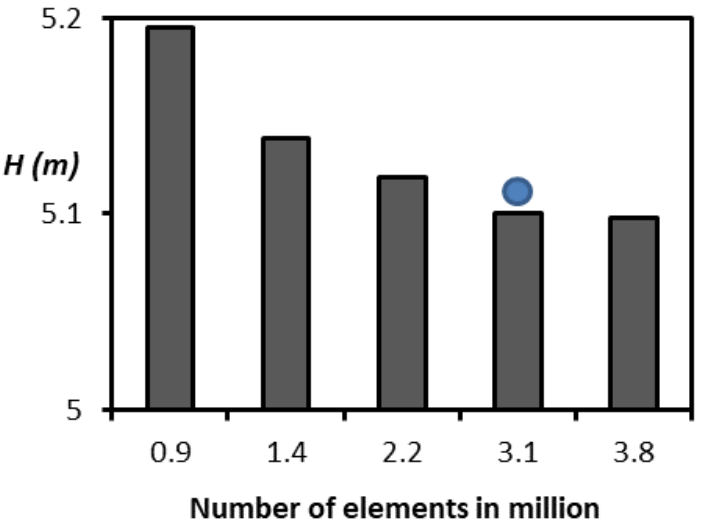
Figure 4. Grid independence test at the design flowrate.